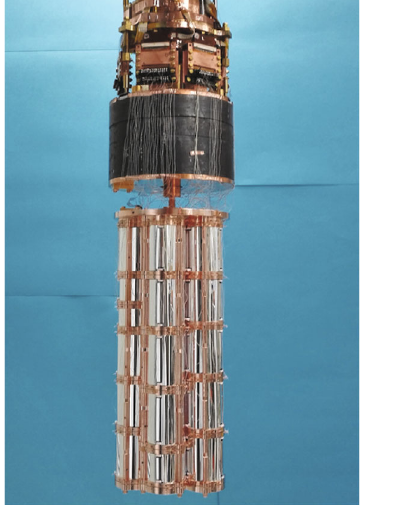
for monitoring the stability of the detectors and of the sys- tem. The remaining available channels might be employed for a future upgrade of the detector.